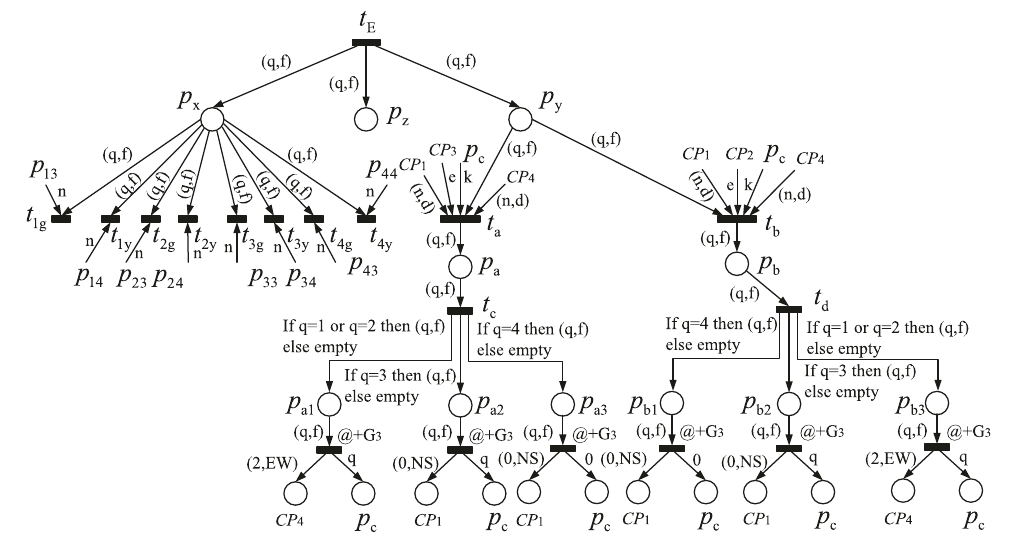
Figure 5: Traffic signal switch control